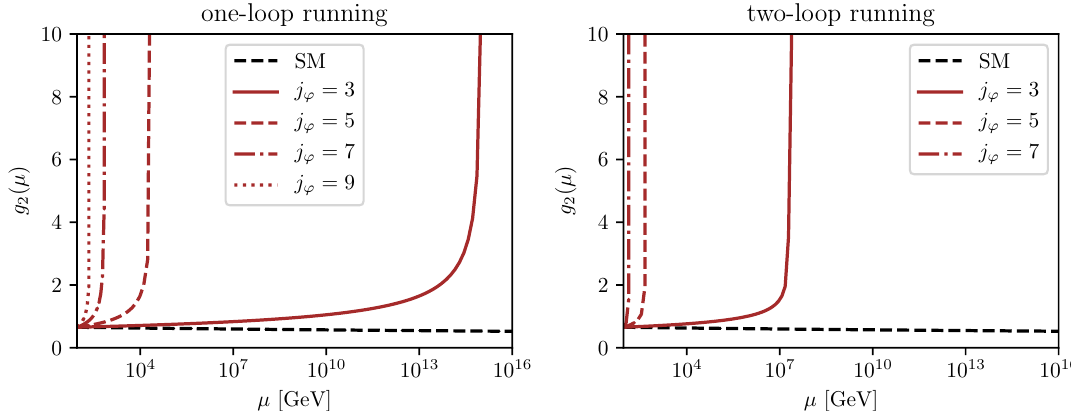
Figure 7. Running of the SU(2) gauge coupling g 2 at one-loop (left panel) and two-loop (right panel), for Y ’ = 0. The black dashed line shows the SM result. The brown lines correspond to di(cid:11)erent representations of the complex scalar. Here, we assumed vanishing initial conditions for all non-SM scalar couplings at (cid:22) = M Z